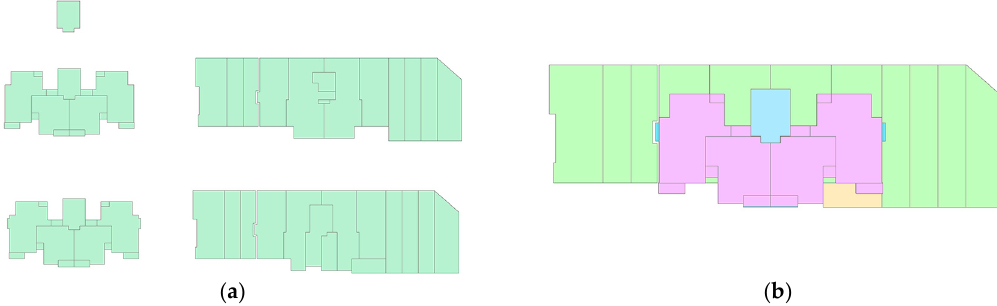
Figure 16. (a) Footprint faces of different floors in different positions; and ( b ) footprint faces of different floors adjusted to the same position.